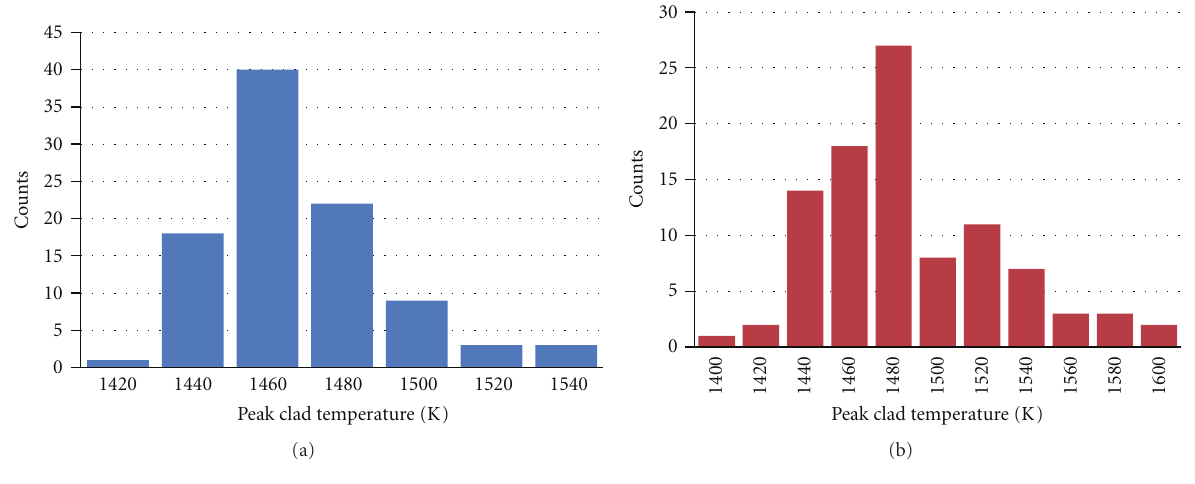
Figure 10: PCT distribution for the PIPE (a) and the CHAN model